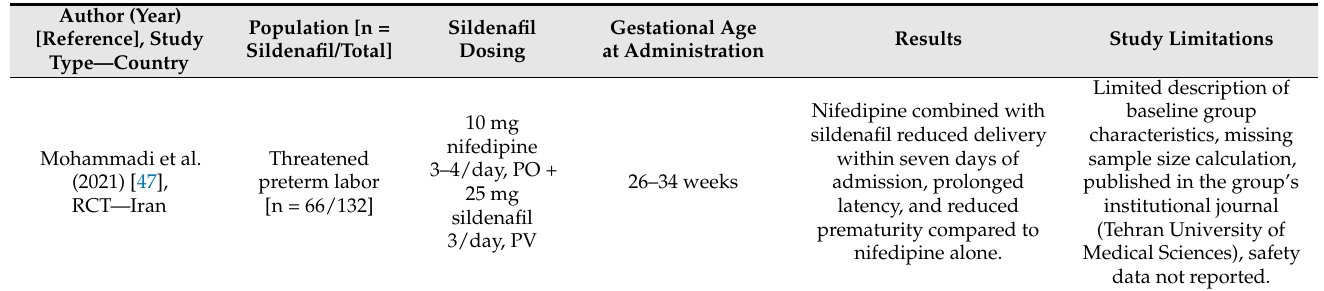
Table 2. RCT’s assessing sildenafil for preterm